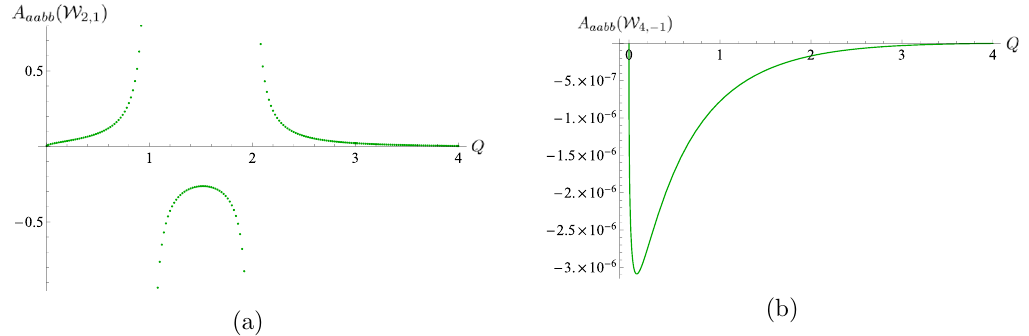
Figure 14 . The bootstrapped A aabb ( W 2 , 1 ) on the left and the analytic A aabb ( W 4 , − 1 ) on the